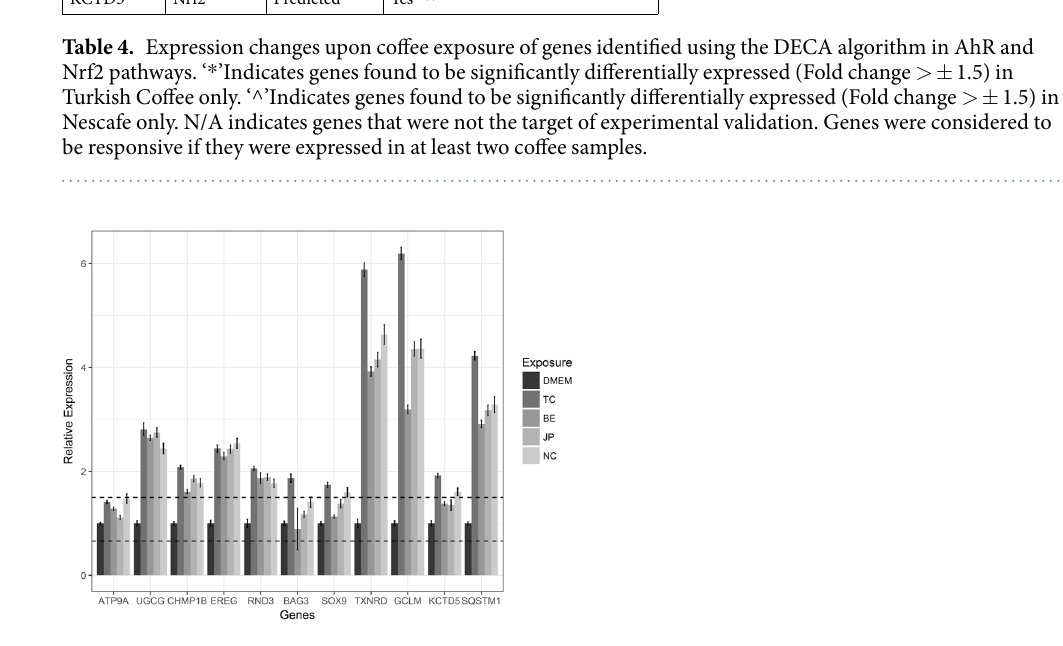
Figure 3. qPCR results of both AhR and Nrf2 pathways provided together for genes predicted using DECA algorithm. The line represents the fold change cut-off limits (1.5 for up regulation and 0.6 for down regulation). CYP1A1 is not shown here as it exceeds the plot limits. TC indicates Turkish coffee, BE indicates Brasil Espirito, JP indicates Java Preanger and NC indicates